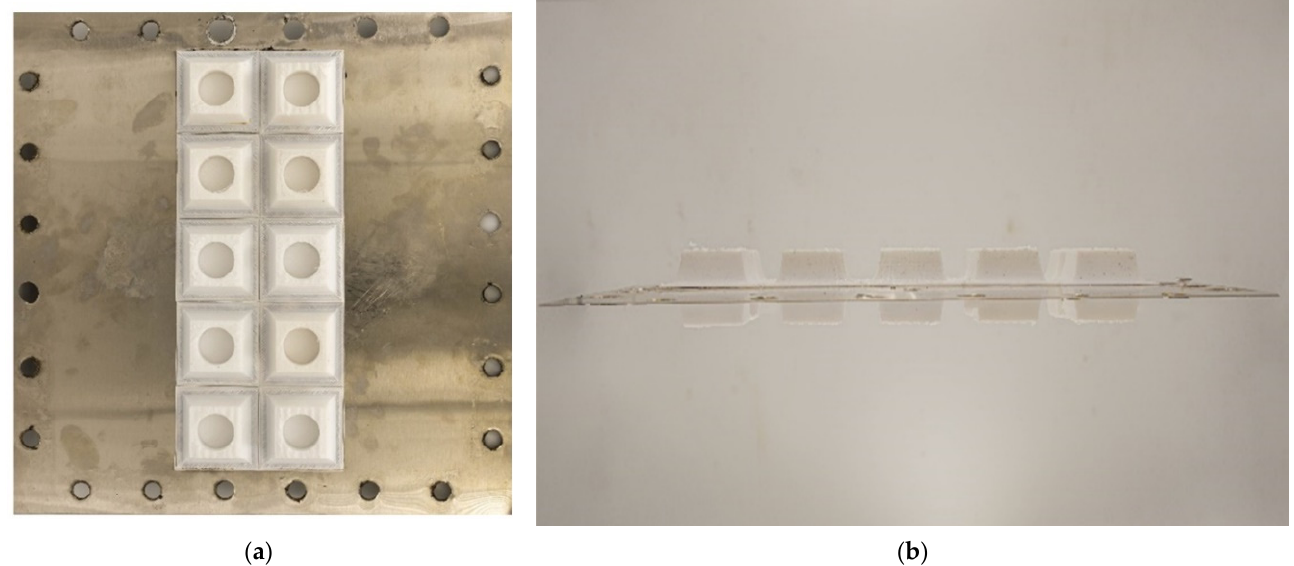
Figure 10. Test model of the photonic crystal plate: ( a ) top view; ( b ) front view.